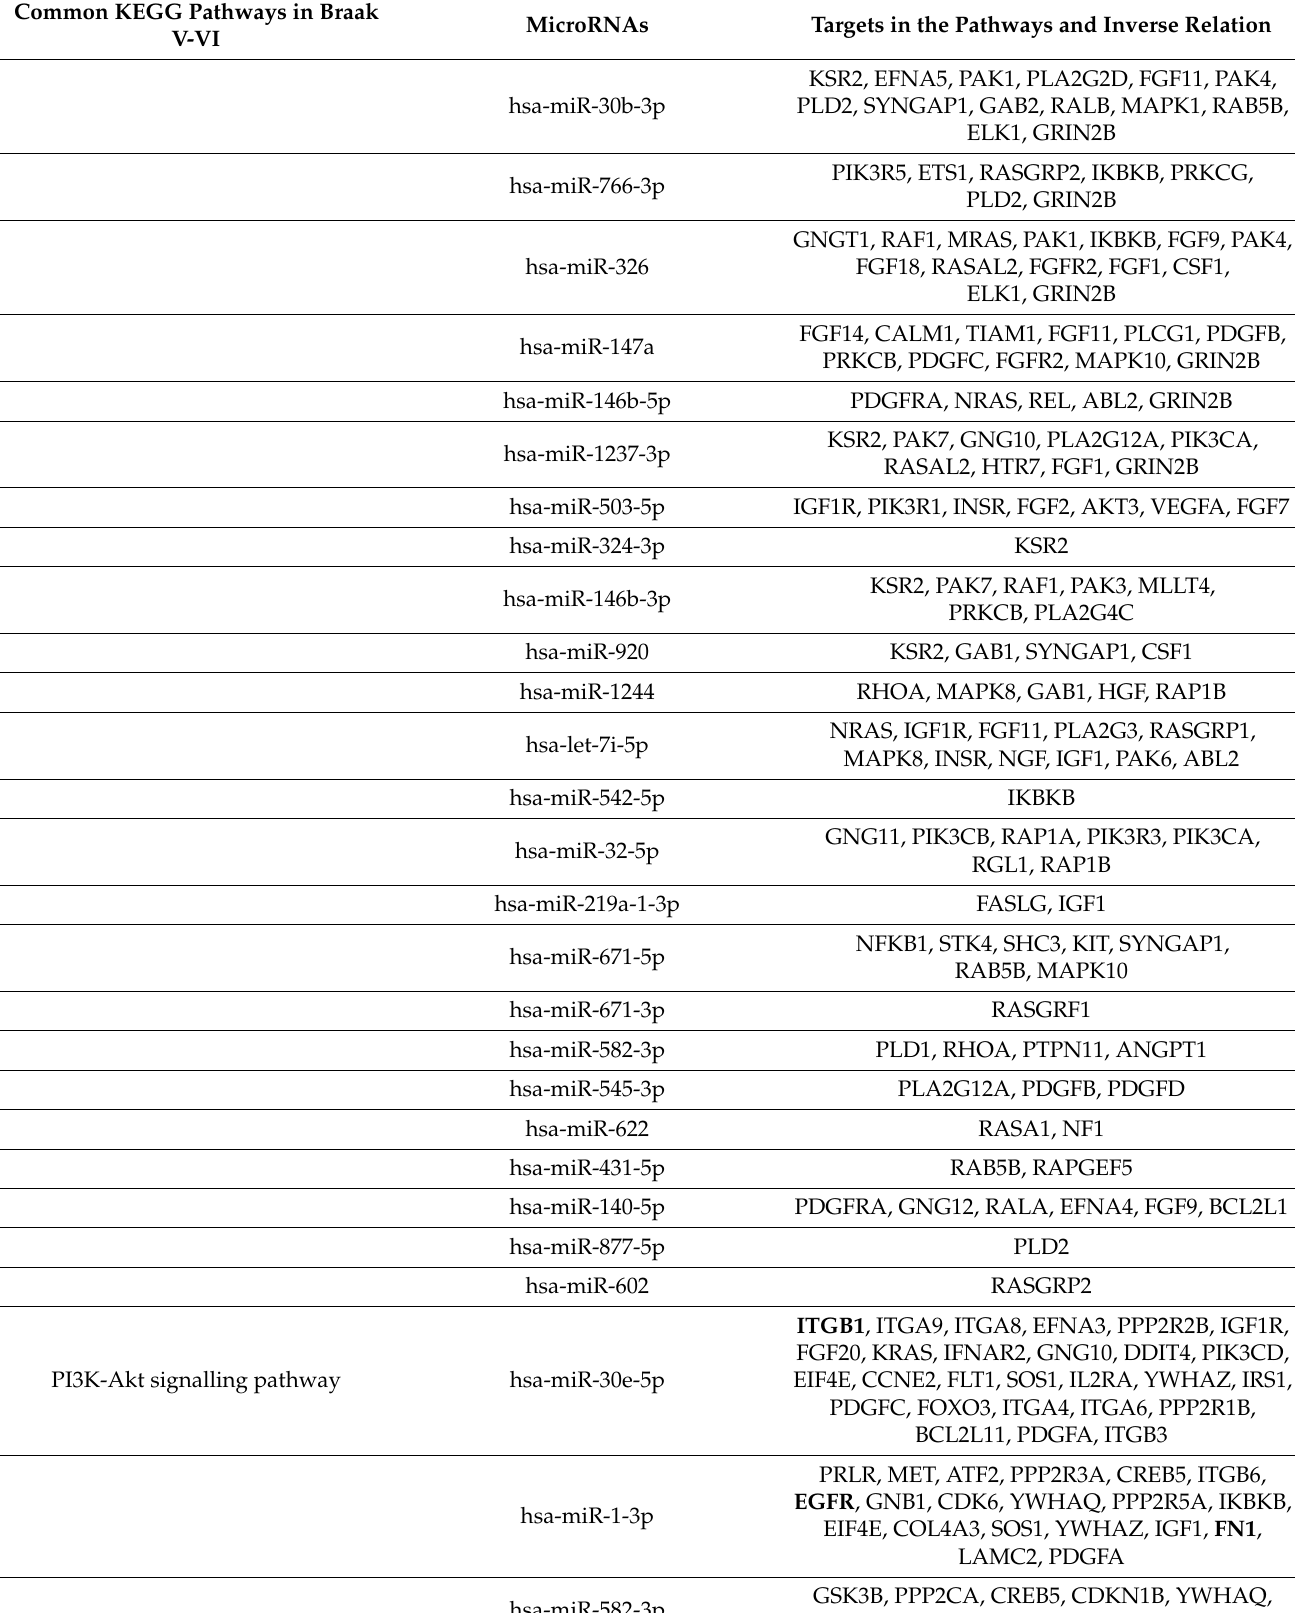
Common KEGG Pathways in